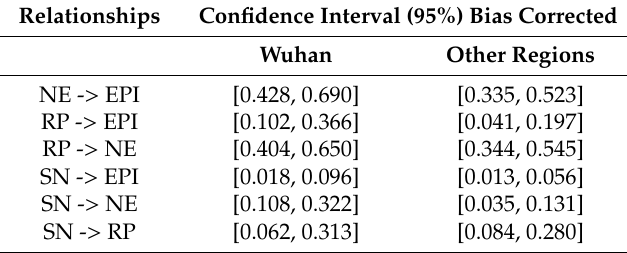
Table 3. Results of